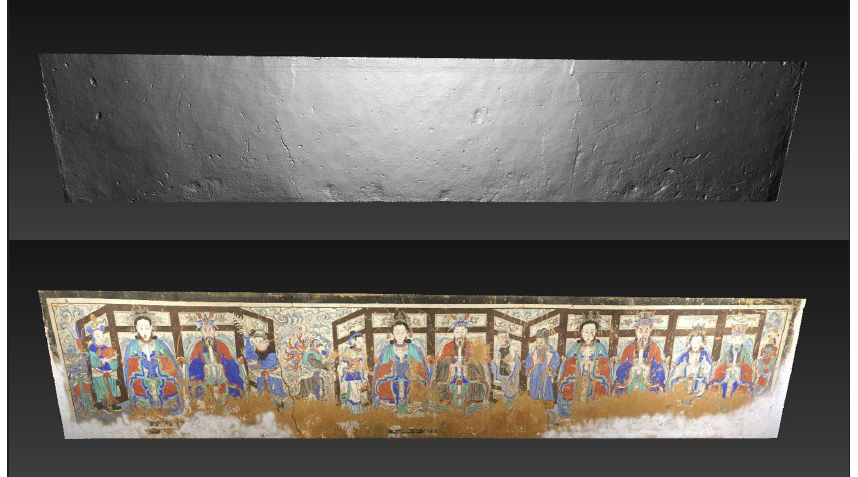
Figure 6: Main mural (10.80 × 2.15 metres) in the Temple of King Wuling of Zhao in Daixian County. The bare wall surface model (top) shows irregularities of the wall allowing for a better condition assessment, while the textured model (bottom) overlays that surface with RGB imagery. Image courtesy of the SDDP